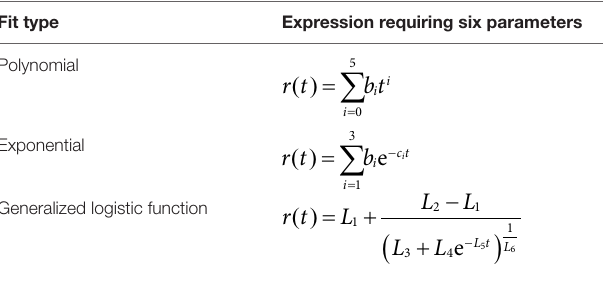
Table 1 | Parameterization expressions for optimal trajectory